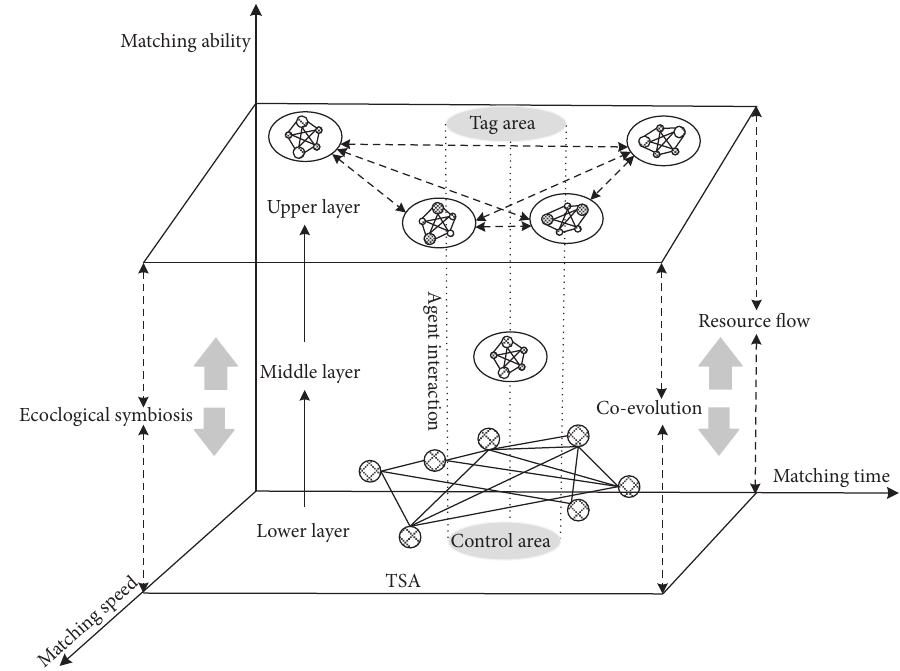
Figure 1: Three-layer echo